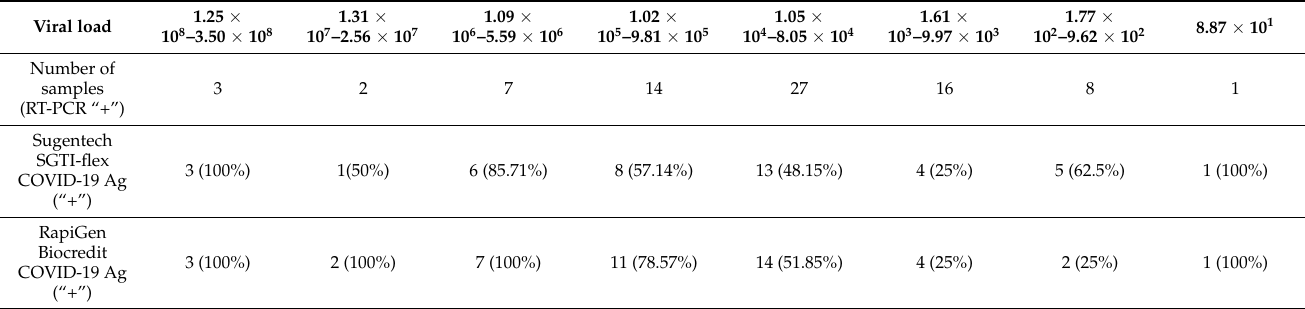
Table A3. Distribution of test results by viral load as measured by quantitative